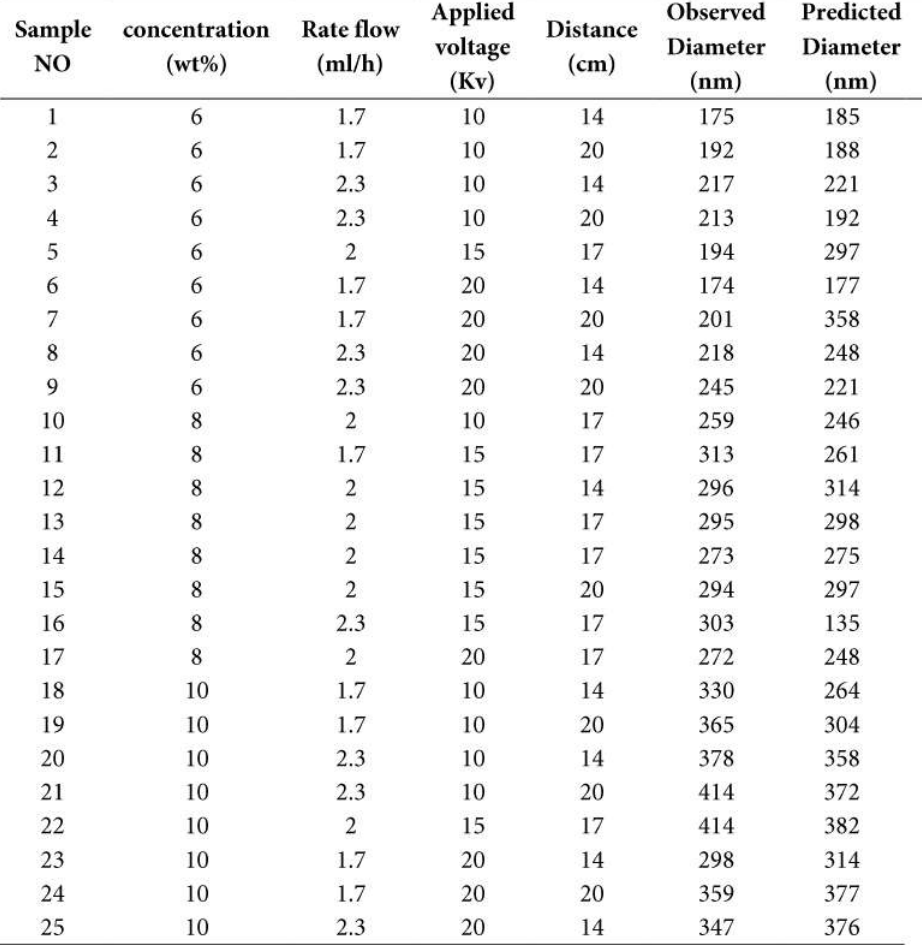
Table 3. Training Data Set for ANNs